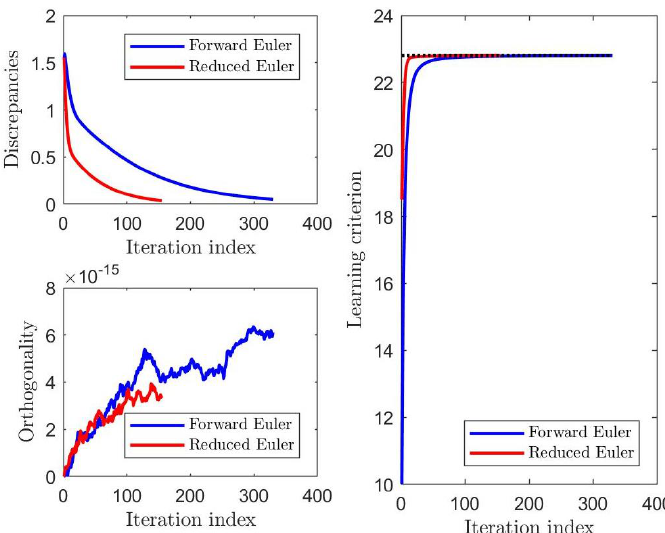
Figure 5. Results of a comparison of the figures of demerit and of the learning criterion for the forward Euler method and for the reduced Euler